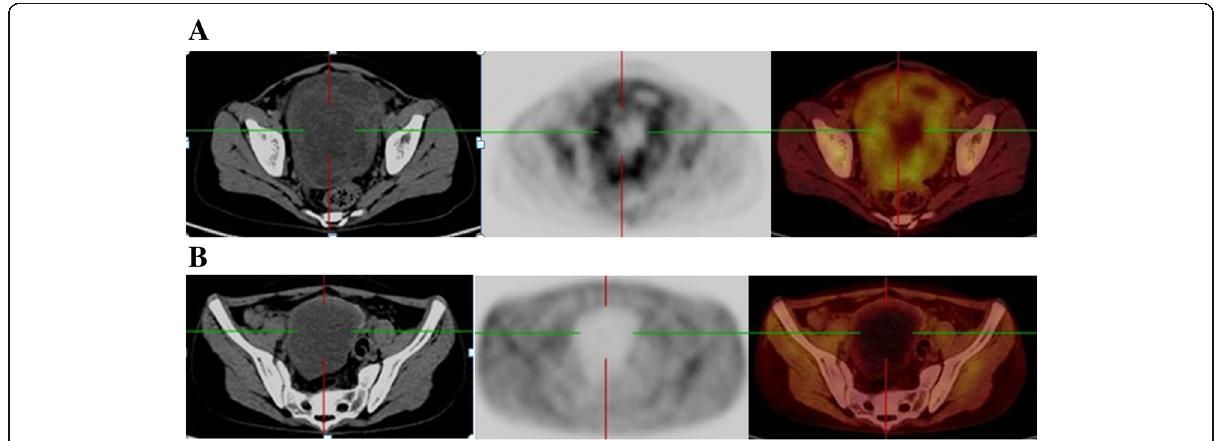
Fig. 4 A 13-year-old boy presented with urinary bladder mass; the mass was proven by a biopsy to be embryonal rhabdomyosarcoma. a Prechemotherapy axial CT (left), axial PET (middle), and axial fused PET/CT (right) revealed metabolically active FDG avid 1ry tumor lesion (SUV = 2.9). b Postchemotherapy axial CT (left), axial PET (middle), and axial fused PET/CT (right) revealed marked regression of the FDG uptake (SUV = 1.5) as well as moderate size regression. The mass was excised without tumor viability detected on